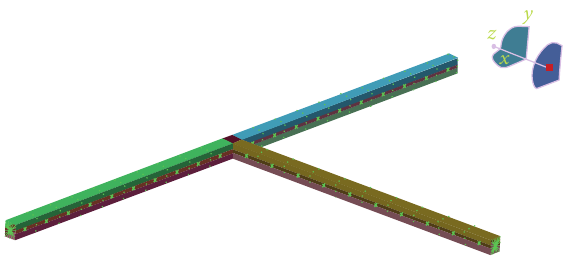
Figure 7: Application case: detailed 3D FE model of the structure.